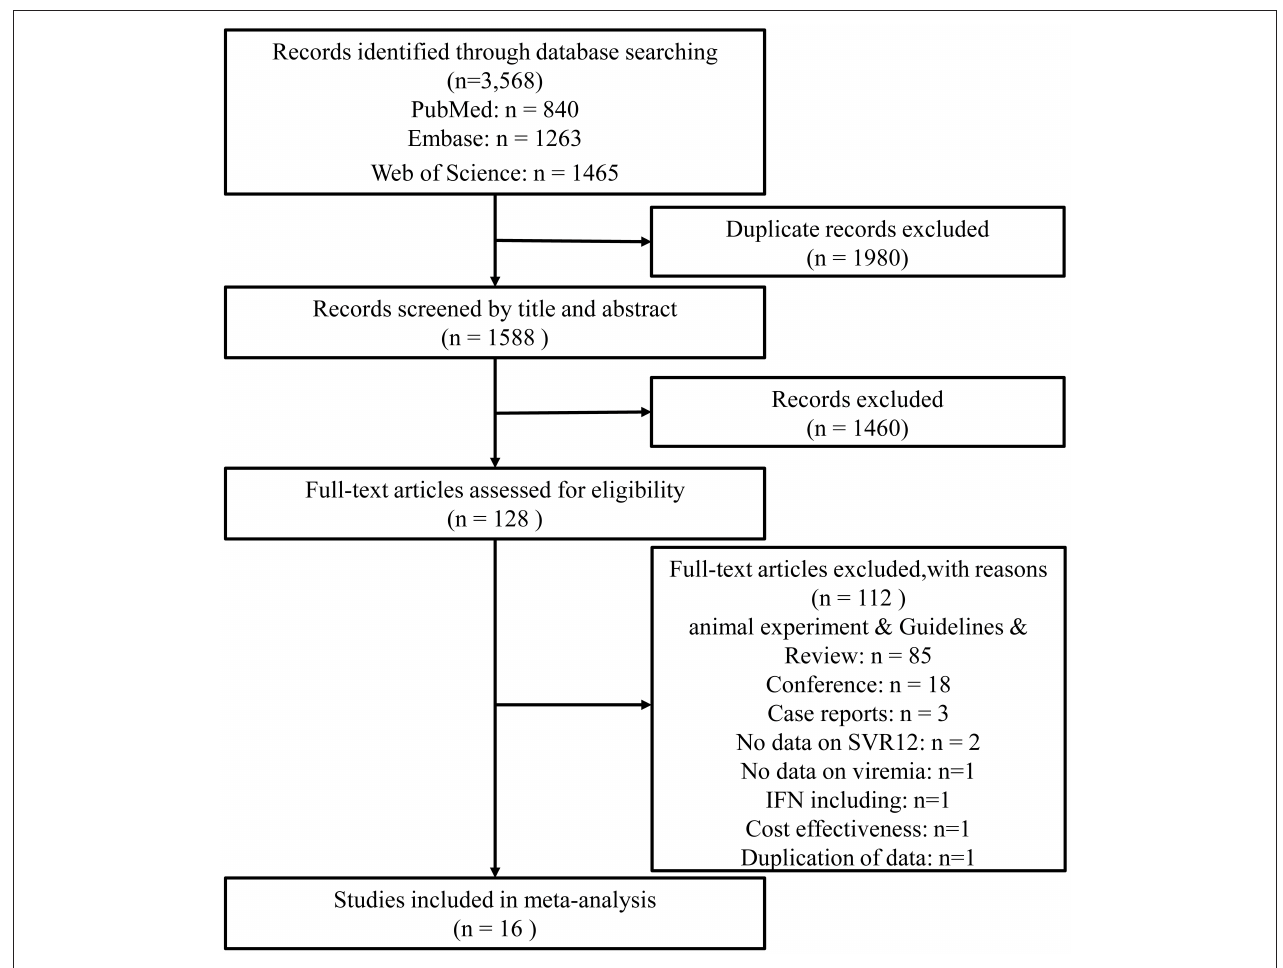
FIGURE 1 | The flow diagram of literature screening and following the preferred reporting items of systematic reviews and meta-analyses (PRISMA).